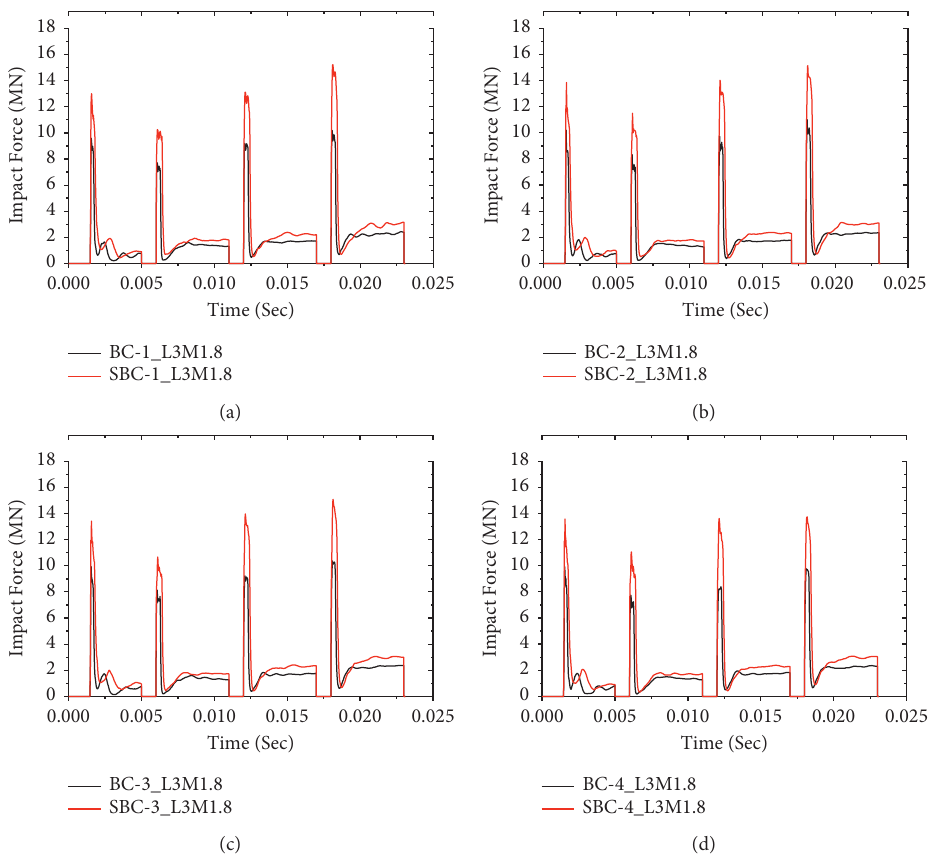
Figure 16: Effect of CFRP wrap on repeated impact capacity of BRC columns: (a) BC-1; (b) BC-2; (c) BC-3; (d)